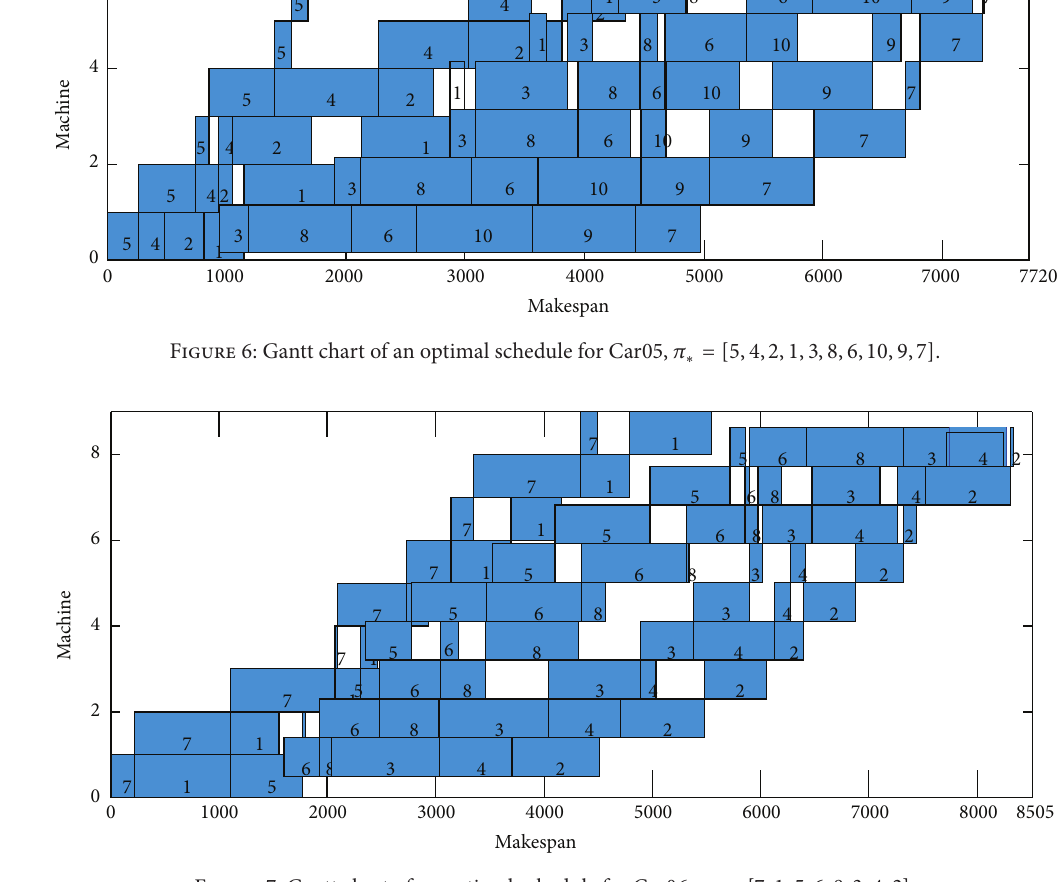
Figure 7: Gantt chart of an optimal schedule for Car06, 𝜋 ∗ = [7, 1,5, 6, 8, 3,4, 2] .